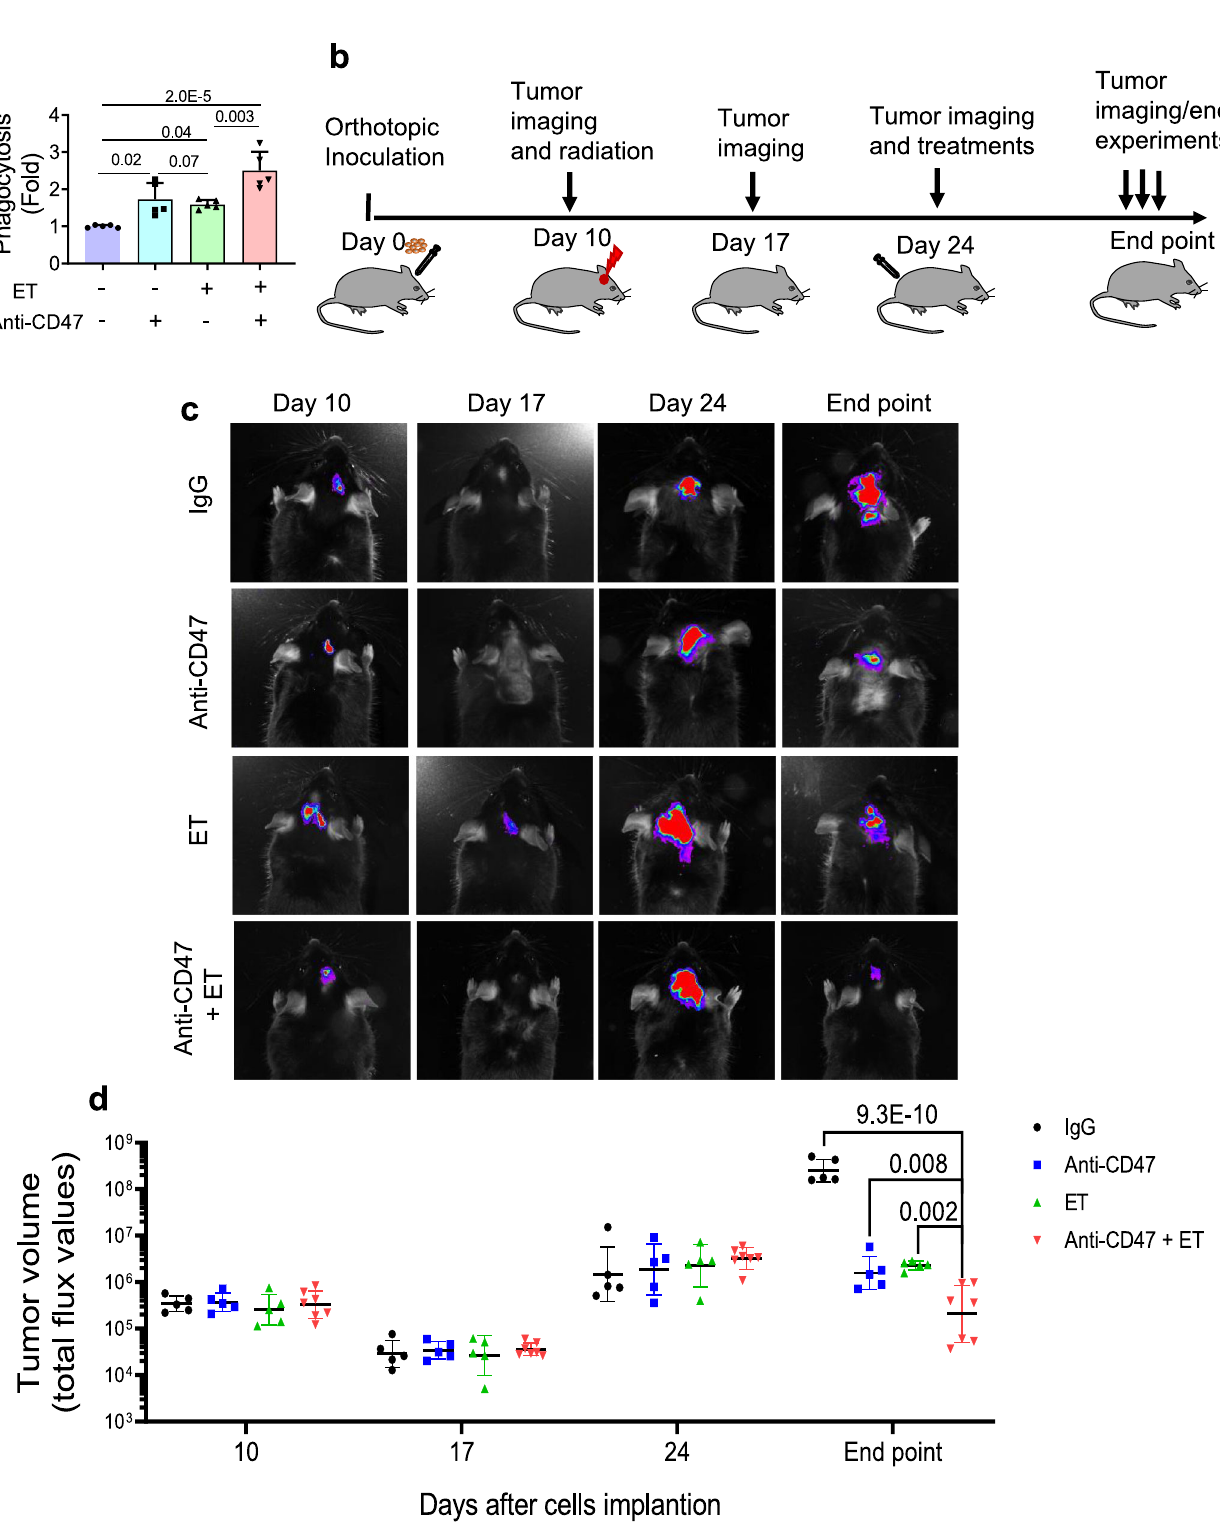
informed consent from all patients. All of the 46 patients underwent intracranial surgery during a period from March 2010 to January 2019, and 34 of them received radiotherapy after the fi rst surgery. All pathological slides of primary matched with recurrent tumors were evaluated according to H&E staining. Animals . Animal use and care protocol of in vivo radiation treatment were approved by the Institutional Animal Use and Care Committee of the University of California Davis (IACUC 15315). Animals were housed and cared for according to